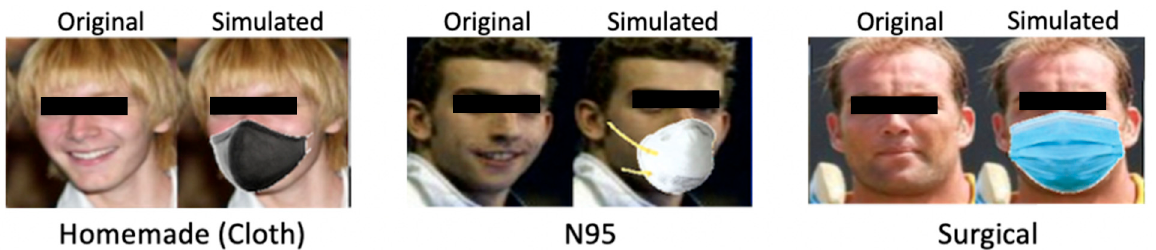
Figure 3. Sample Simulated Images.